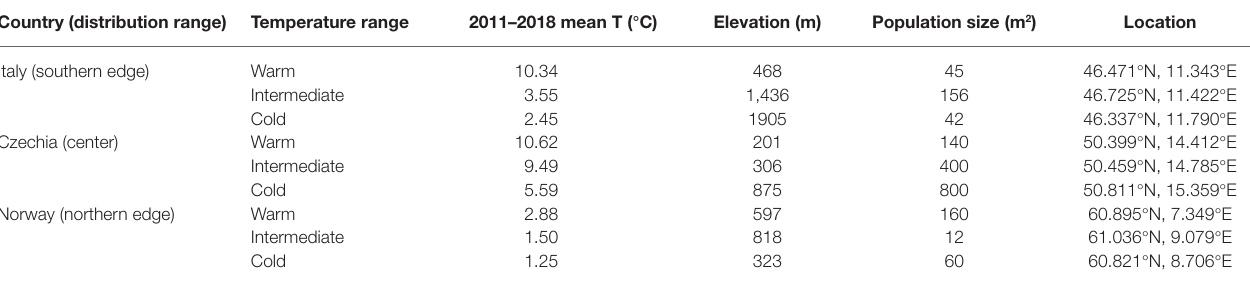
TABLE 1 | Temperature range, mean annual temperature, elevation, population size (m 2 ), and location of selected populations in the three European